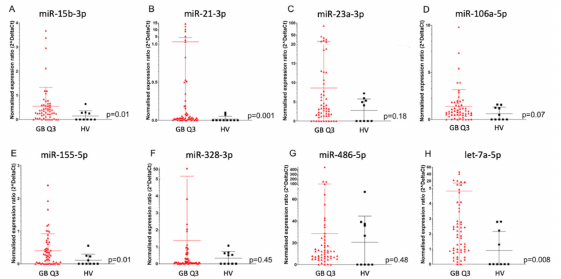
Figure 3. MicroRNA expression in SEC + CD44 EV. Normalized expression ratio (2ˆdeltaCt) of eight microRNAs ( A – H ) in SEC + CD44 EV from glioblastoma patients ( n = 55) versus HV ( n = 10, average of two time points). ( A ) miR-15b-3p, ( B ) miR21-3p, ( C ) miR-23a-3p, ( D ) miR-106-5p, ( E ) miR-155-5p, ( F ) miR-328-3p, ( G ) miR-486-5p, ( H ) let-7a-5p. Expression levels were compared using the Mann–Whitney U test. Bars depict the median value and the interquartile